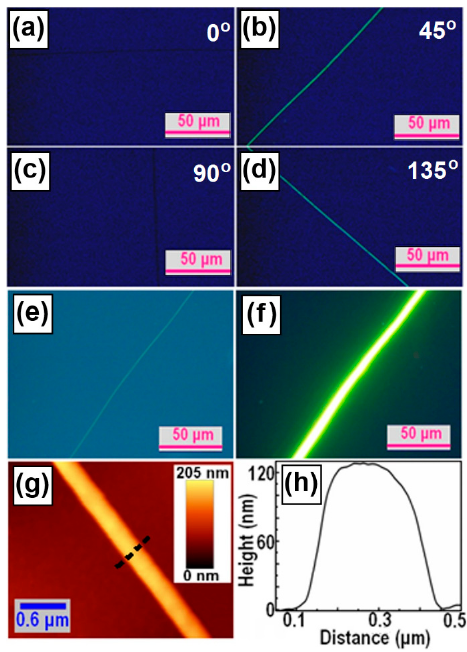
Figure 3. ( a – d ) Polarization optical microscopic images of a single F8BT fiber; ( e , f ): transmission and fluorescence optical microscopic image of the single F8BT fiber; and ( g , h ) AFM height image and plot of the profile of the fiber, respectively.